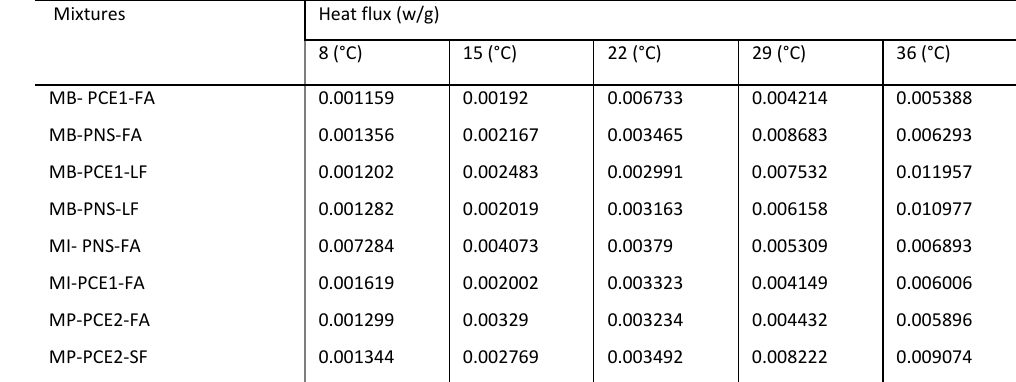
Figure 1. Hydration heat flow of CEM mixtures with different SPs and SCMs. Table 3. Maximum heat flux for CEM mixtures at varying